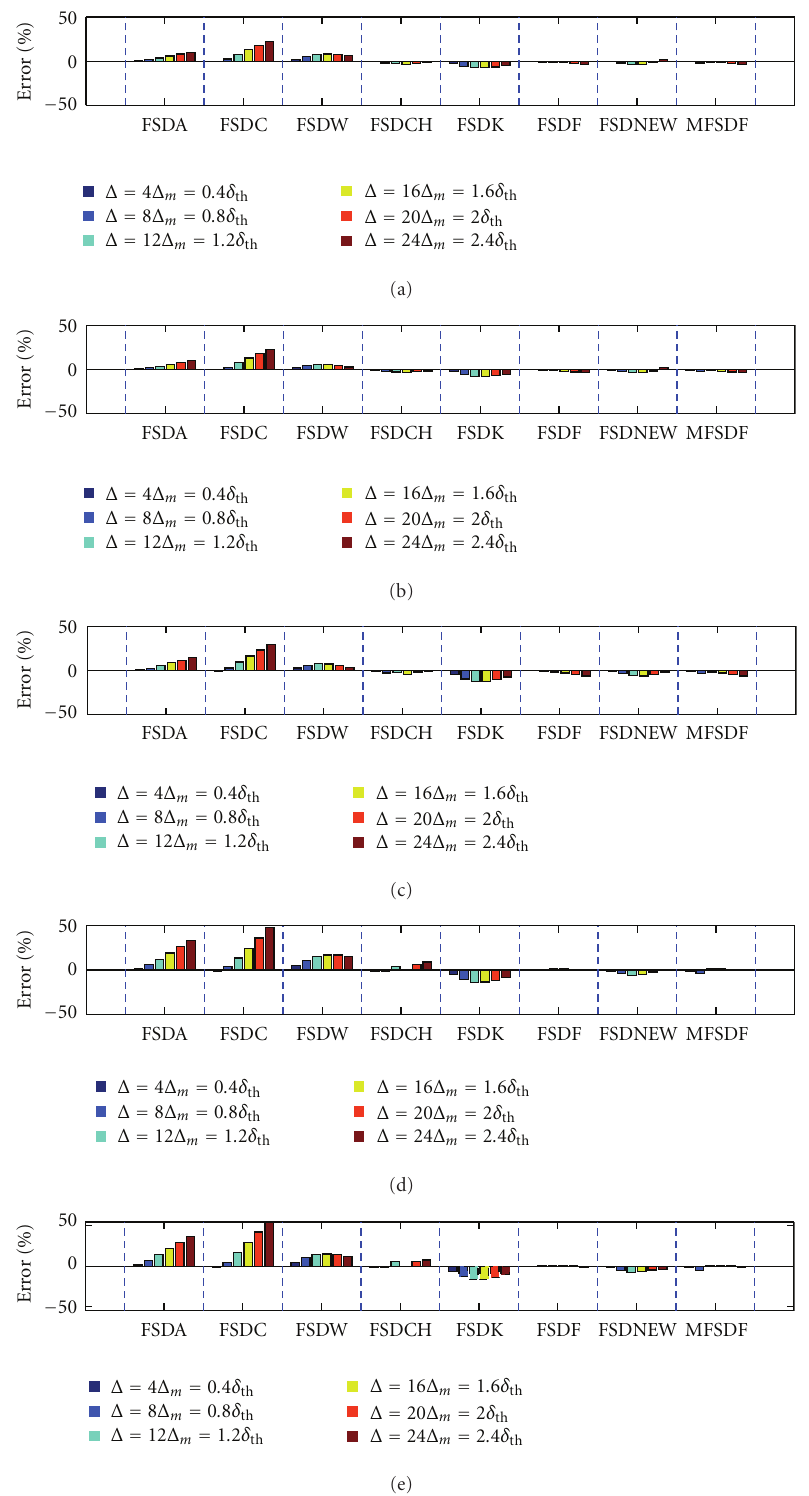
Figure 3: Percentage error of the model prediction from (cid:5) Σ gen (cid:6) obtained from DNS for LES filter widths Δ = 4 Δ m = 0 . 4 δ th ; Δ = 8 Δ m = 0 . 8 δ th ; Δ = 12 Δ m = 1 . 2 δ th ; Δ = 16 Δ m = 1 . 6 δ th ; Δ = 20 Δ m = 2 . 0 δ th and Δ = 24 Δ m = 2 . 4 δ th for (a–e) cases